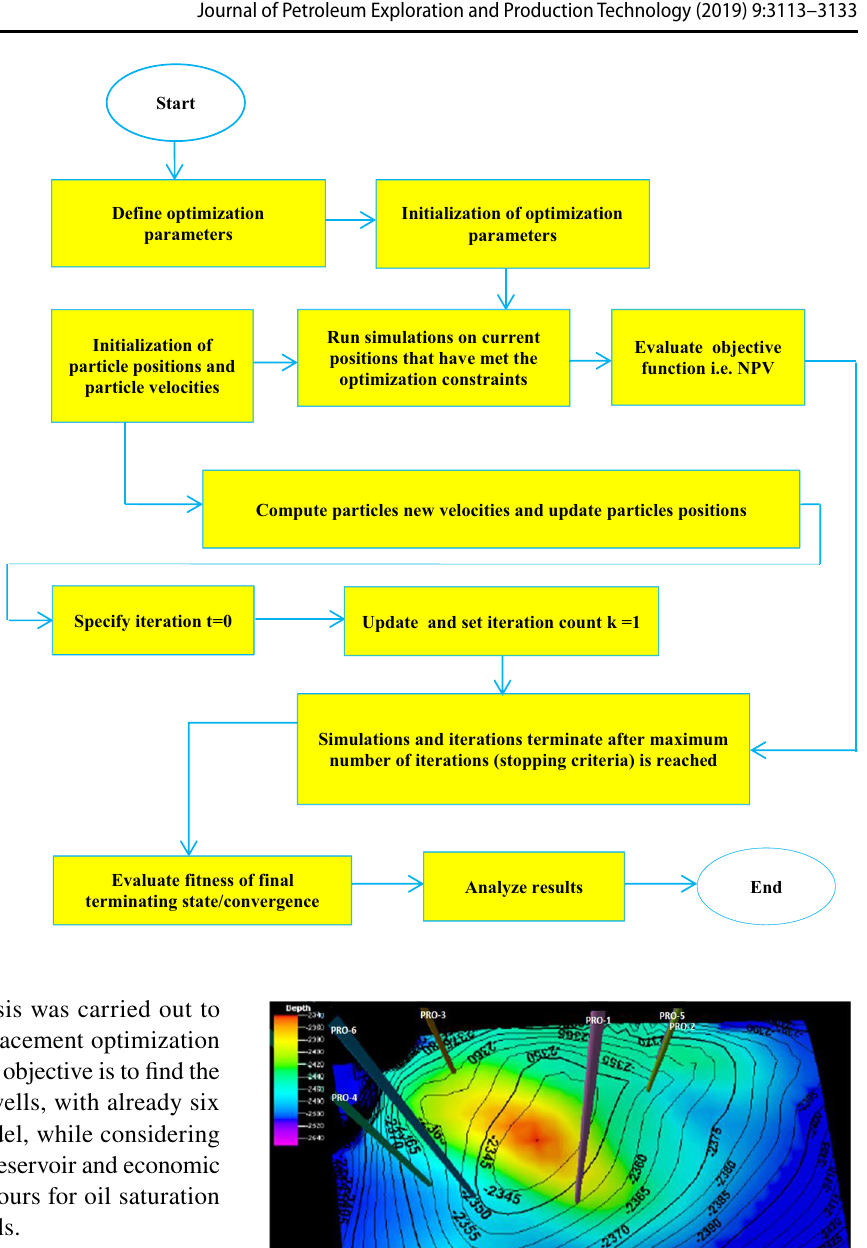
Fig. 1 Flowchart of methodol- ogy used for the optimization process